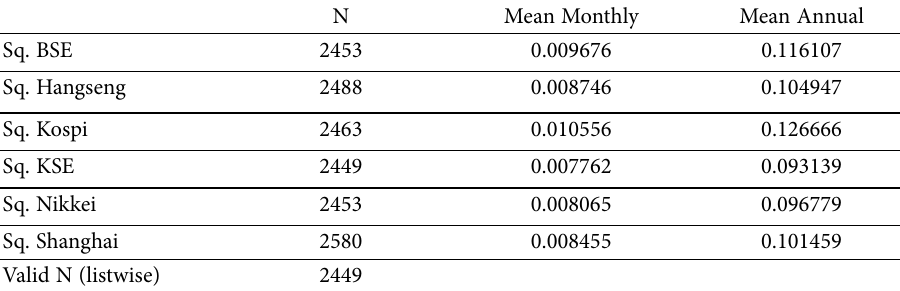
Table 2. Descriptive analysis (monthly & annual returns)